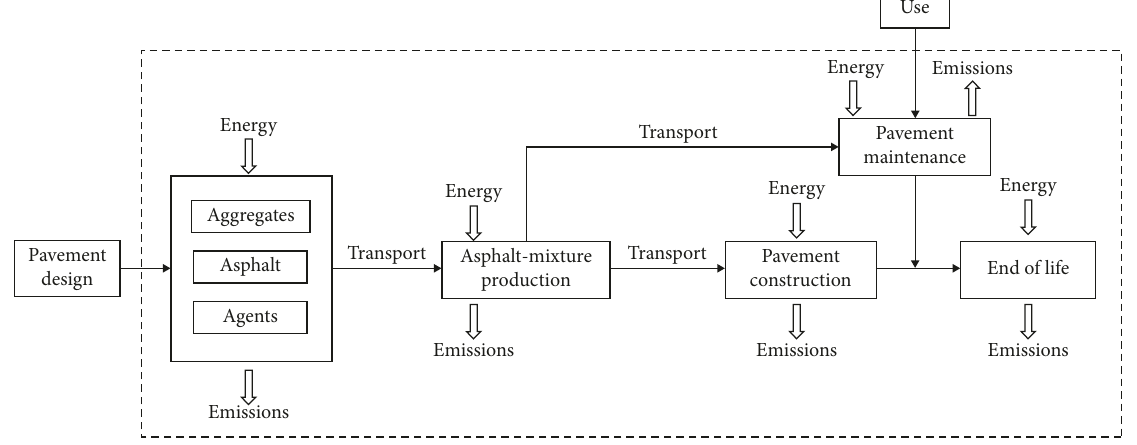
Figure 1: The scope of pavement LCA model in this study.